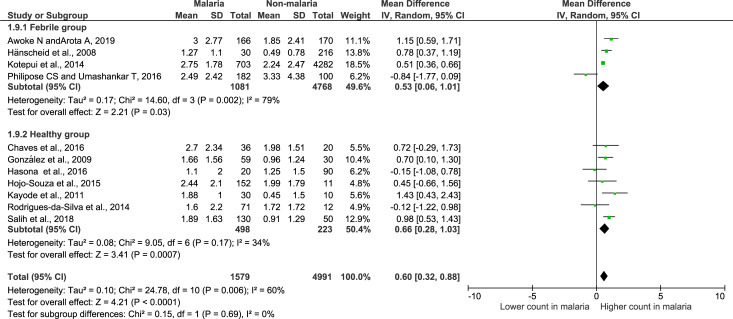
Forest plot of the NL ratio among included studies.Forest plot showing the NL ratio in the malaria and non-malaria groups. [1000/μL] refers to 1000 per microliter; “IV" in "IV, Random” refers to Inverse variance; "Total" in top row refers to number of patients included; A green square in the horizontal line refers to the mean difference for each of included study.